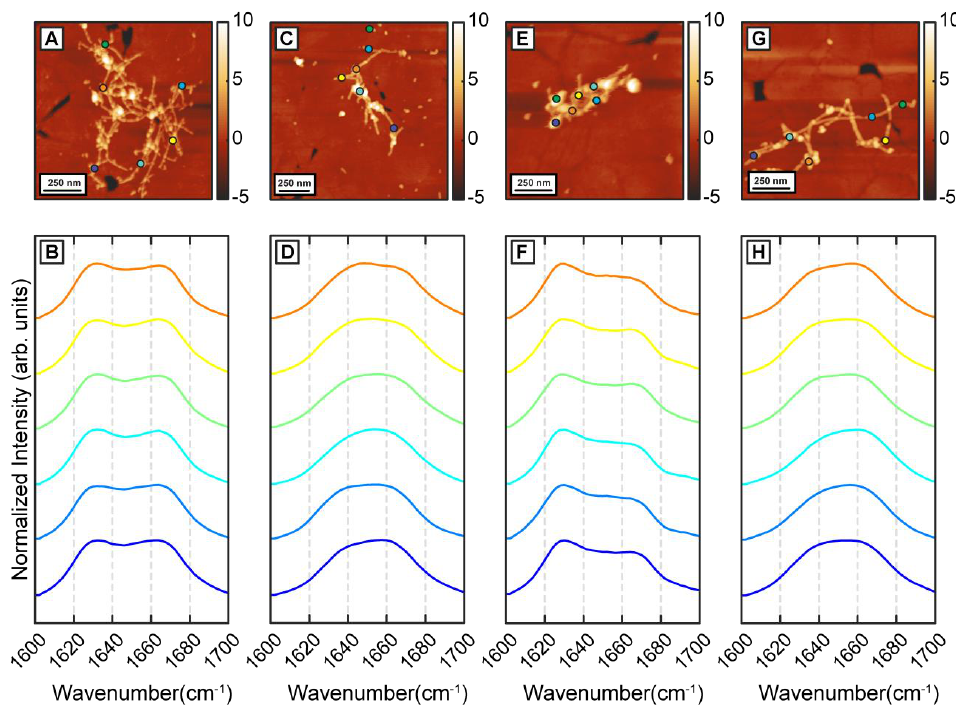
Figure 3. AFM- IR characterization of Aβ42 aggregates in presence of β -carotene (1:1 molar ratio) for 24 h and 72 h. ( A ) AFM topograph of one type of Aβ42 fibrillar structural polymorph obtained after 24 h and ( B ) representative IR spectra obtained from them. ( C ) AFM topograph of other type of structural polymorph obtained after 24 h and ( D ) representative IR spectra obtained from them. ( E , G ) AFM image of two types of fibrillar structural polymorphs obtained after 72 h and ( F , H ) their representative IR spectra. Dots on the AFM topographs show the corresponding location of IR spec- tra.